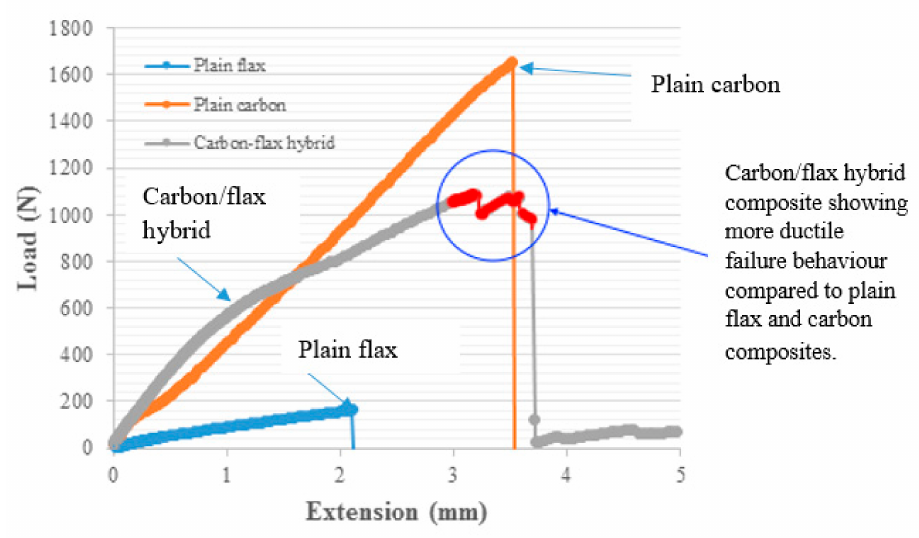
Figure 4. Load vs. extension curves for di ff erent composites.